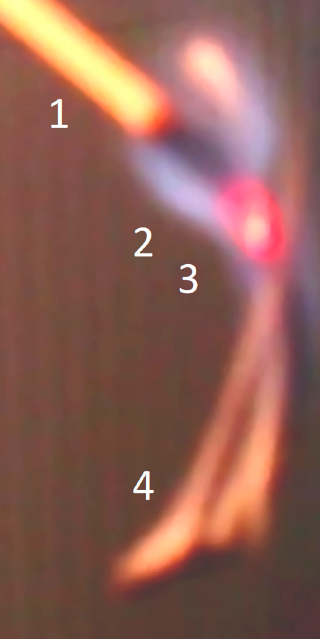
Figure 10 . A freely burning stick with four regions marked, see text for details. The diameter of the stick was 1.2 mm.